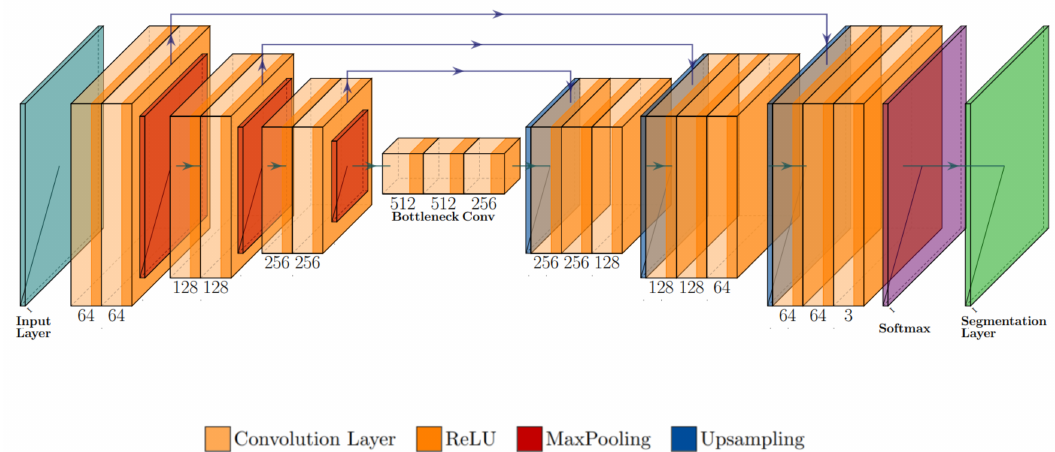
Figure 8. An illustration of the U-Net architecture of our